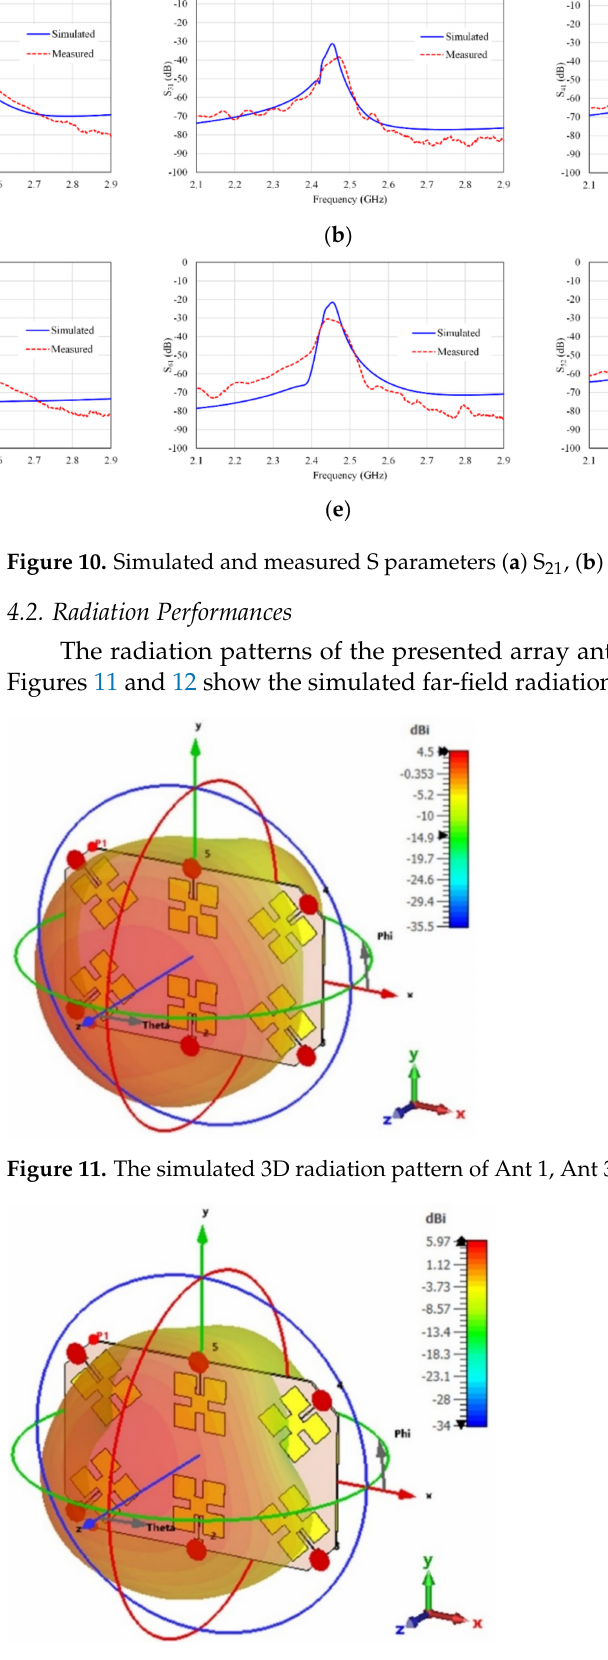
Figure 12. The simulated 3D radiation pattern of Ant 2, and Ant 5 at 2.45